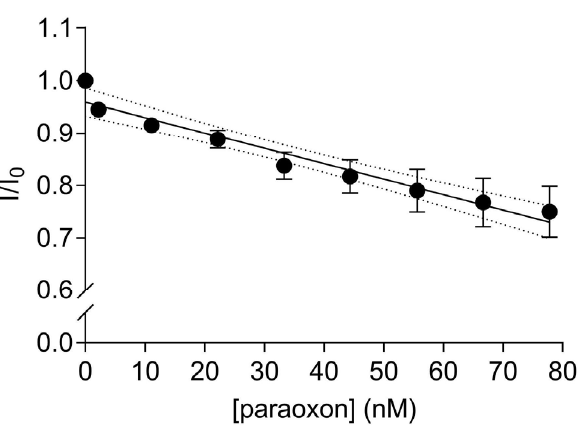
Figure 5. Ratios of the fluorescence intensity (mean ± SD, n = 3) of 67 nM IAEDANS-labelled EST2- S35C in the presence (I) and the absence (I 0 ) of increasing concentrations (nM) of paraoxon at a maximum wavelength of emission of 458–460 nm. Dotted lines represent the 95% confidence inter- val for the linear regression. for the linear